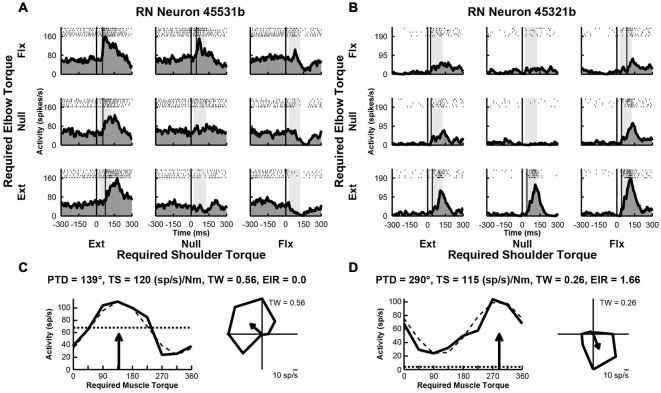
Activity of exemplar RN neurons. (A) Rasters and histograms for each perturbation condition (arranged in joint-torque space) displaying the activity of an RN neuron that responded maximally to perturbations that required an extensor torque at the shoulder and a flexor torque at the elbow to counter the applied torques. (B) Activity of a RN neuron that responded maximally to perturbations that required a flexor torque at the shoulder and an extensor torque at the elbow. (C,D) Directional tuning of the corresponding RN neurons. Left sub-panels illustrate linear plots of overall activity vs. joint-torque angle. Unloaded baseline activities and cosine fits are shown as dotted and dashed lines, respectively. Right sub-panels show polar plots of the perturbation-related activity (baseline removed) in joint-torque space. PTD, preferred-torque direction; TS, torque-slope; TW, tuning width; EIR, excitation-inhibition ratio.